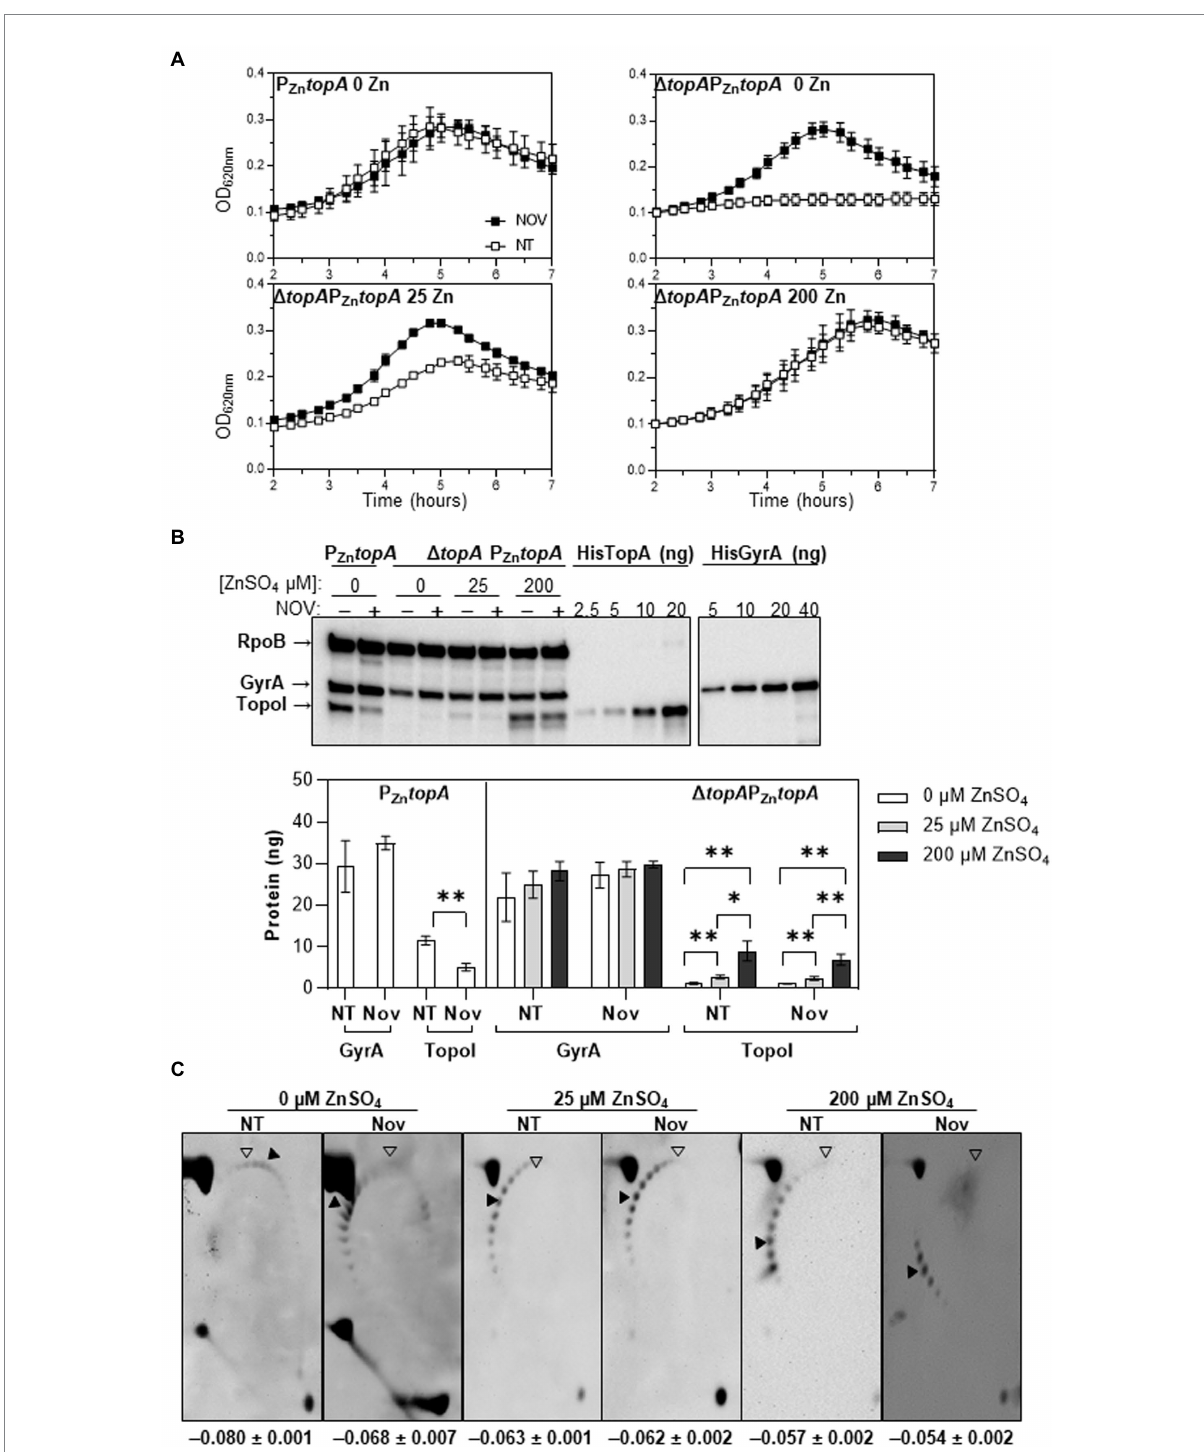
FIGURE 4 Effect of the treatment of Δ topA P Zn topA with Nov on growth and Sc. Strains P Zn topA and Δ topA P Zn topA were grown either in media without or with 150 μ M ZnSO 4 , respectively, until OD 620nm = 0.4 (spectrophotometer measurement). Cells were washed and diluted 100-fold in media containing diverse ZnSO 4 concentrations. Cultures were either not treated (NT) or treated with Nov at 0.25 × MIC. Samples were taken at OD 620nm = 0.15–0.4, except for Δ topA P Zn topA grown without ZnSO 4 , in which samples were taken after 240 min. (A) Growth curves of indicated strains monitored in a TECAN Infinite 200 PRO reader. (B) Western-blot analysis of GyrA and TopoI proteins. Experiments were performed as described in Figure 2 legend. (C) 2D-agarose gel electrophoresis of plasmid DNAs. Chloroquine concentrations used in the first and the second dimension were 5 and 15 μ g/ml, respectively. Sc density ( σ ) values are shown (averages ± SD). An empty arrowhead indicates the topoisomer that migrated with Δ Lk = 0 in the second dimension and that had a Δ Wr of − 31 (the number of positive supercoils introduced by 15 μ g/ml chloroquine). A black arrowhead points to the more abundant topoisomer. Results are the mean ± SD of three independent replicates. Statistical significance two-tailed Student ′ s t -test, * p ≤ 0.05; ** p ≤